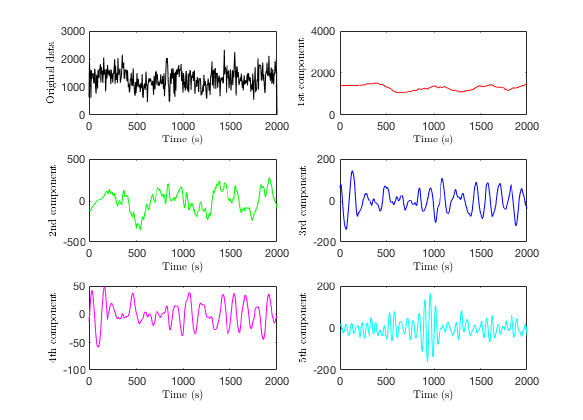
Figure 4. SSA decomposition